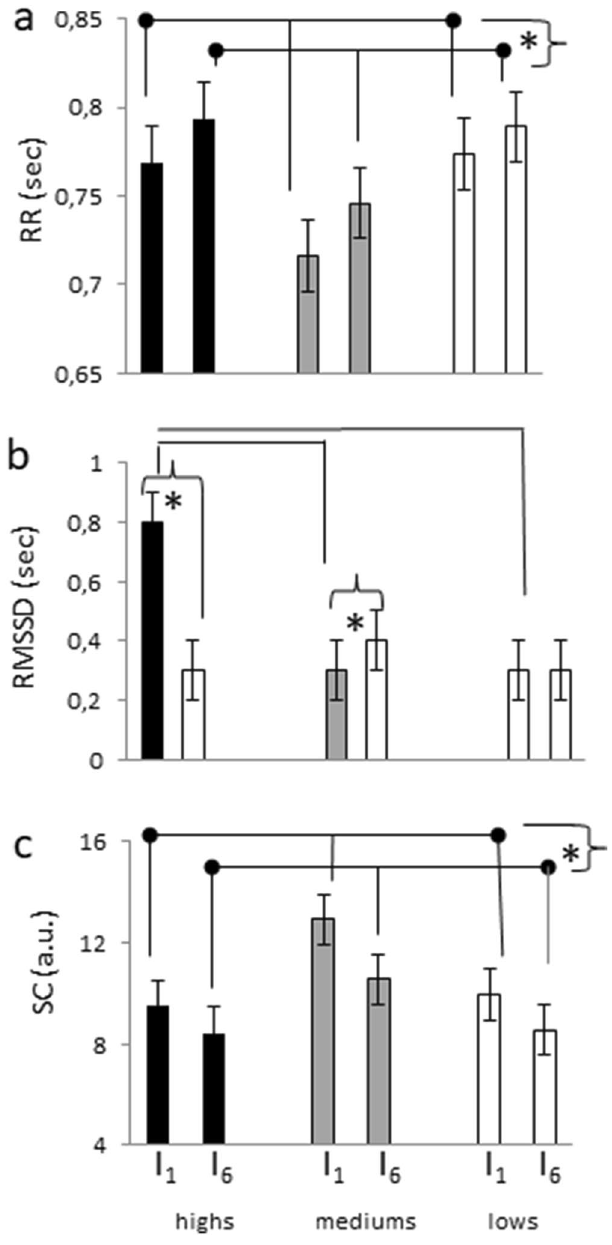
Figure 1. Autonomic variables (mean, SEM). ( a ) Mean RR (interbeat interval, sec; ( b ) Root Mean Square of Successive Differences (RMSSD, sec); ( c ) mean Tonic Skin Conductance (SC, arbitrary units). I 1 and I 6 : first and last Interval. Stars indicate significant differences between Intervals independently from hypnotizability for RR and SC (a: I 1 < I 6 ; c: I 1 > I 6 ) and ( b ) between Intervals in highs and mediums for RMSSD. Lines ( b ) indicate significant hypnotizability differences in I 1